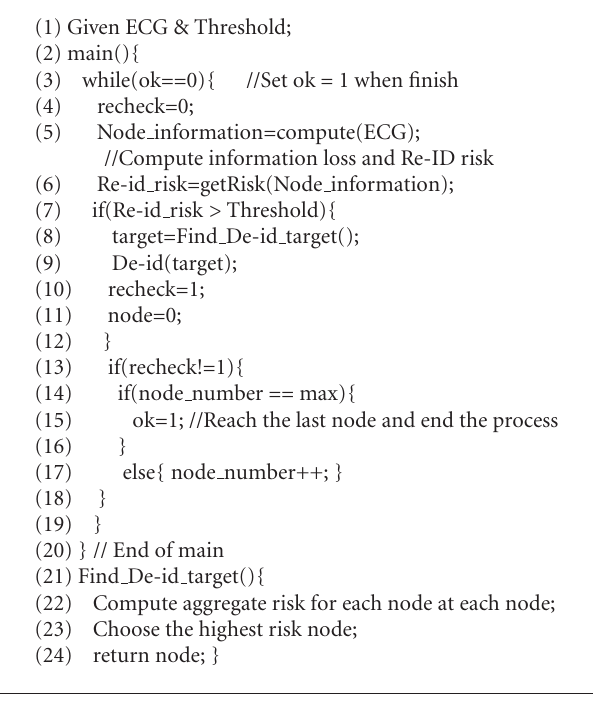
Algorithm 2: Privacy Tailor algorithm.